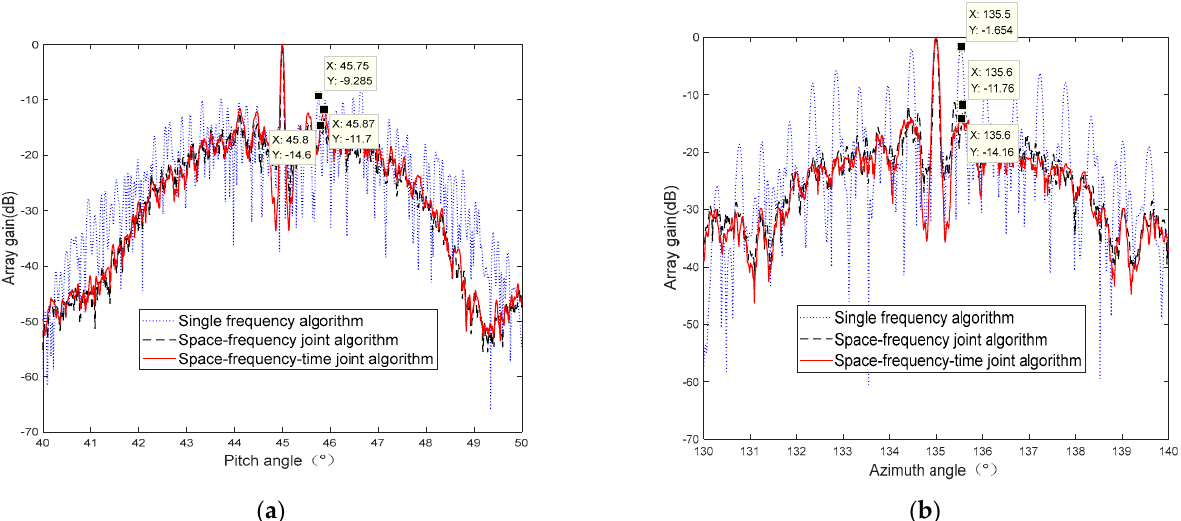
Figure 10. The beampattern under elevation angle of 30 and azimuth angle of 120. ( a ) The elevation pattern; ( b ) the azimuth pattern.